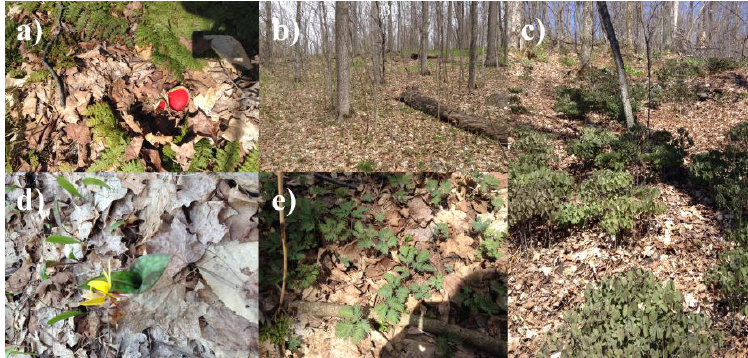
Figure 3. Examples of spring plants found in similar environmental conditions to the wild leek in Gatineau Park, Quebec including ( a ) ferns, ( b ) patches of emerging white trillium and red trillium, ( c ) blue cohosh (late May), ( d ) trout lily, and ( e ) squirrel corn or dutchman’s breeches. Photos were taken in May